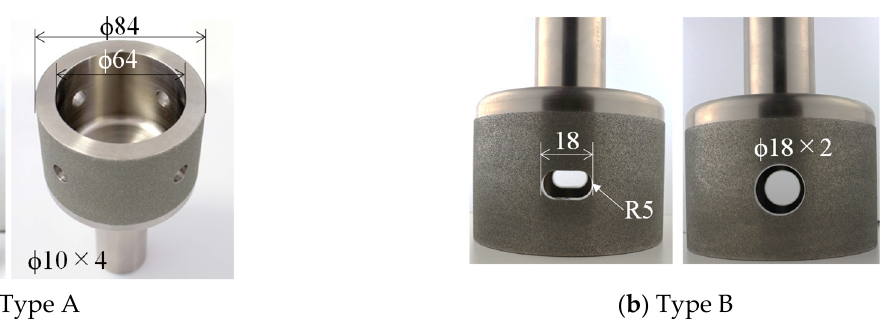
Figure 4. Configuration of grinding wheel and holes for optical path.